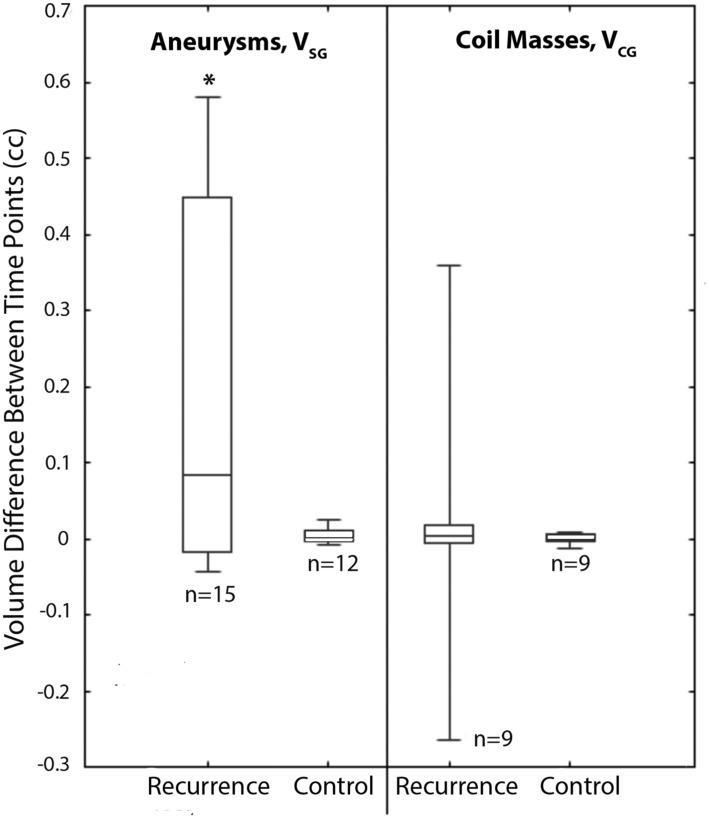
Aneurysm sac growth (V
SG) and Coil mass growth (V
CG) in the recurrence and control cohorts.The box and whisker plots show quartiles and the p-values are from paired one-tail Wilcoxon tests for hypothesizing that the aneurysm sac will grow (null hypothesis, H
0: V
SG ≤ 0; alternative hypothesis, H
A: V
SG > 0) and the coil mass will compact (H
0: V
CG ≥ 0; H
A: V
CG < 0).